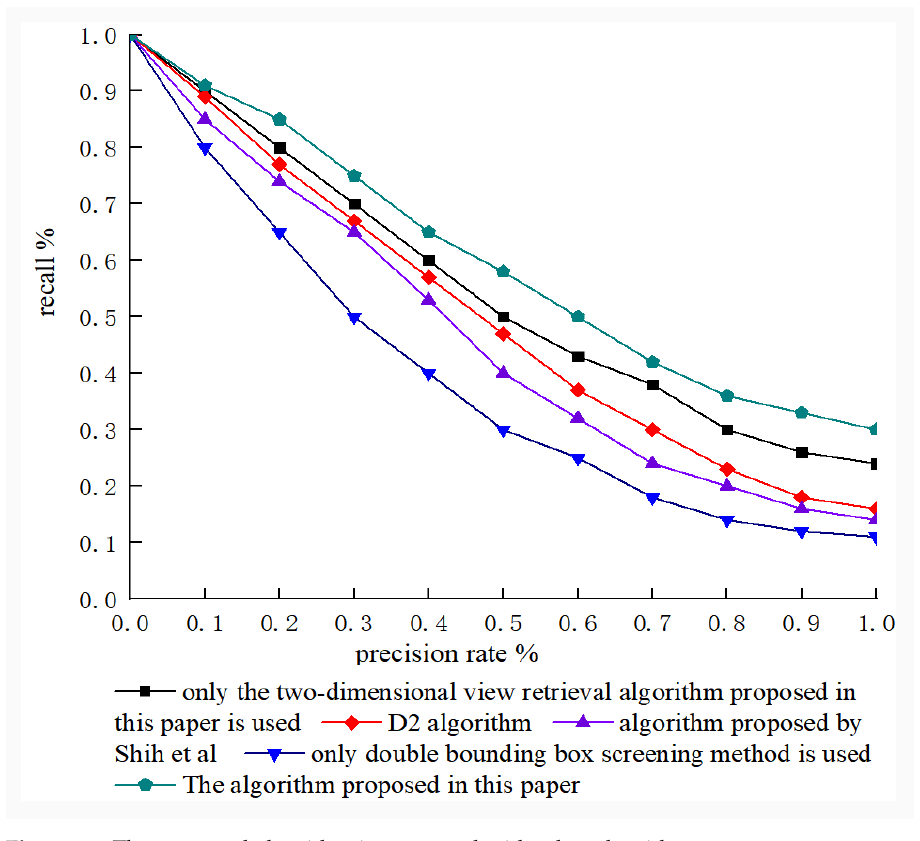
Figure 10. The proposed algorithm is compared with other algorithms. Table 4. The time of the CAD model corresponding to the current point cloud data retrieved from the model base.